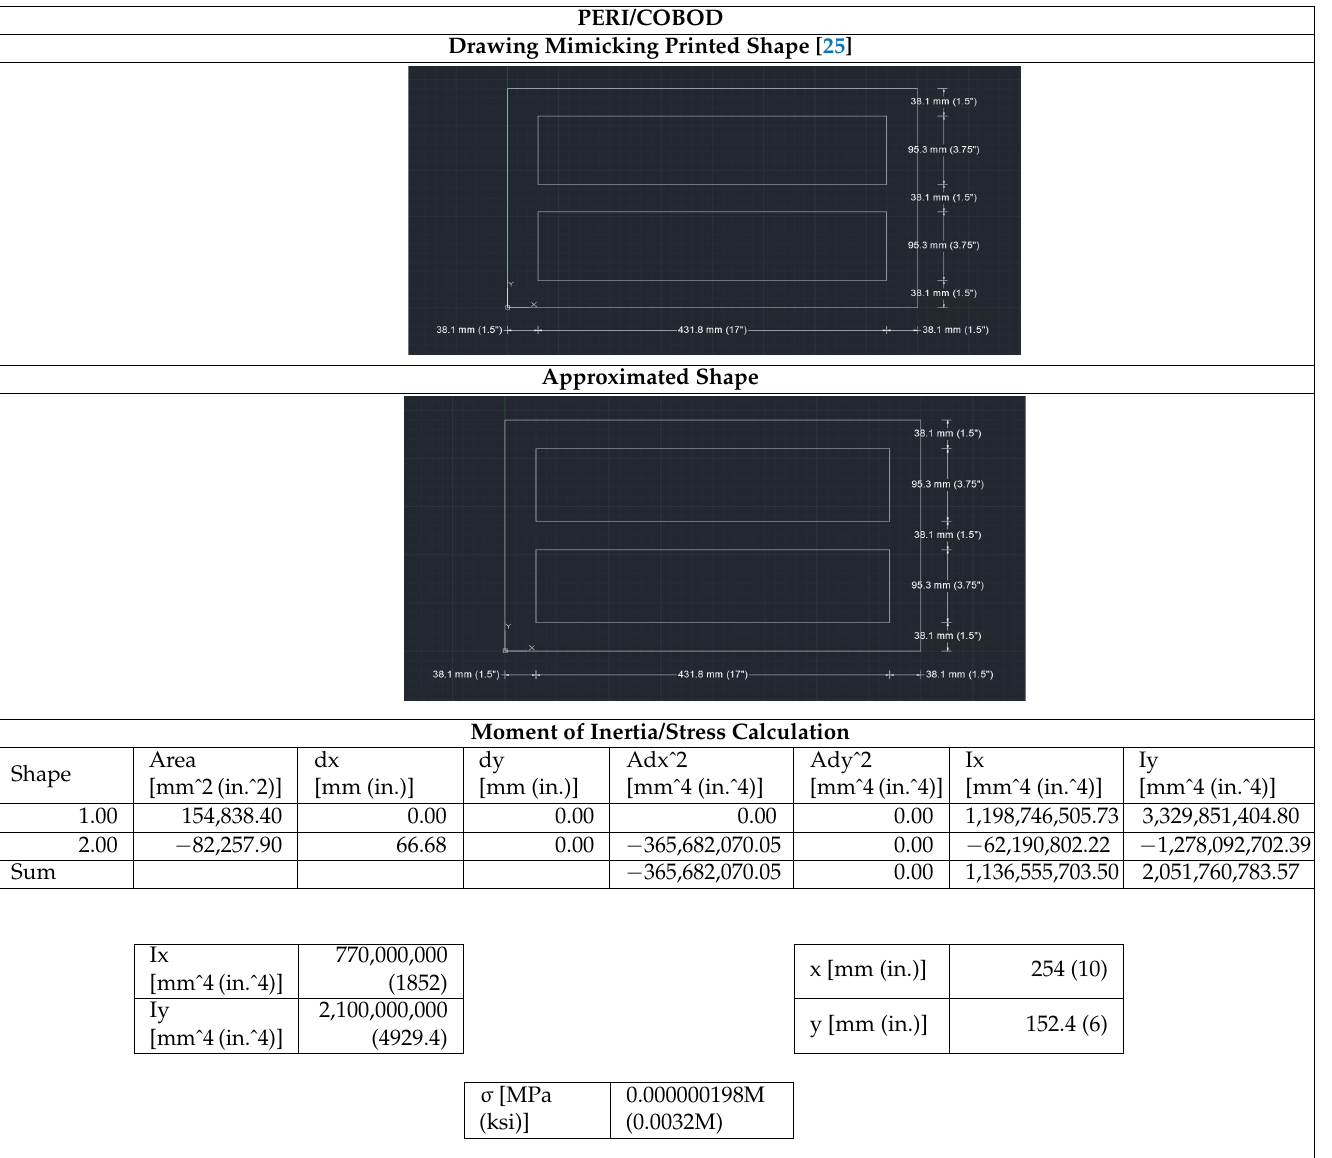
Table A2. PERI/COBOD wall